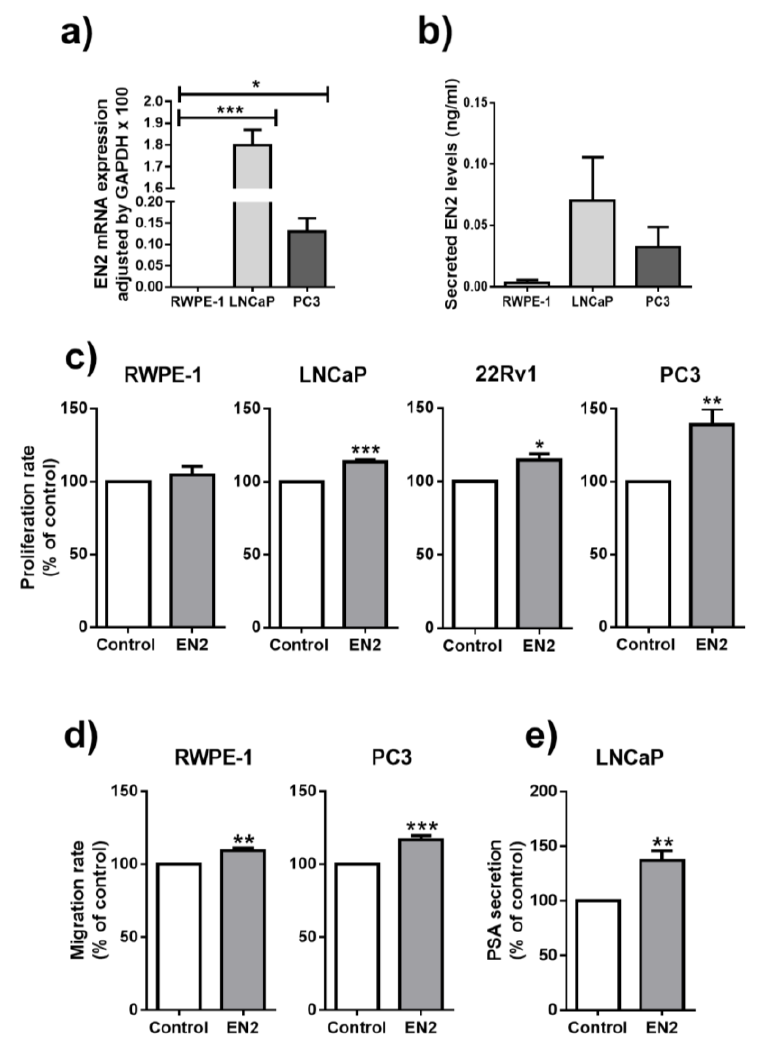
Figure 2. EN2 expression and its functional role in prostate-derived cell lines. ( a ) EN2 mRNA expression levels in normal-like prostate cell line, RWPE-1, and PCa cell lines, LNCaP and PC3, determined by qPCR and adjusted by glyceraldehyde-3-phosphate dehydrogenase (GAPDH) levels. ( b ) EN2 secretion levels from RWPE-1, LNCaP, and PC3 cell lines, determined by ELISA. ( c ) Effect of 24 h treatment with EN2 protein on cell proliferation rate in (from left to right) RWPE-1, LNCaP, 22Rv1, and PC3 cell lines compared to vehicle-treated controls. ( d ) Effect of 24 h treatment with EN2 protein on cell migration rate in RWPE-1 and PC3 cell lines, compared to vehicle-treated control. ( e ) PSA secretion from LNCaP cell line treated with EN2 protein compared with vehicle-treated controls (after 24 h culture) determined by a specific ELISA kit. Data represent mean ± SEM and they are expressed as percentage of vehicle-treated controls (set at 100%) within experiment. * p ≤ 0.05, ** p < 0.01, *** p < 0.001 indicate significant differences compared to control.